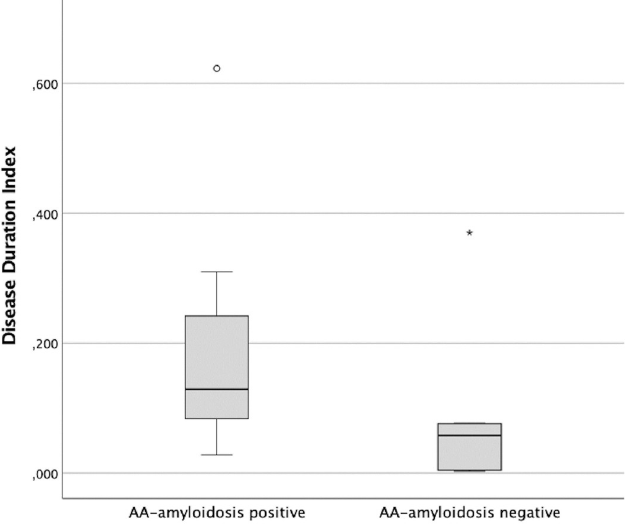
Fig 4. Box and whisker plot of Disease Duration Index in cats with and without AA-amyloidosis (n = 20, all belonging to shelter C).